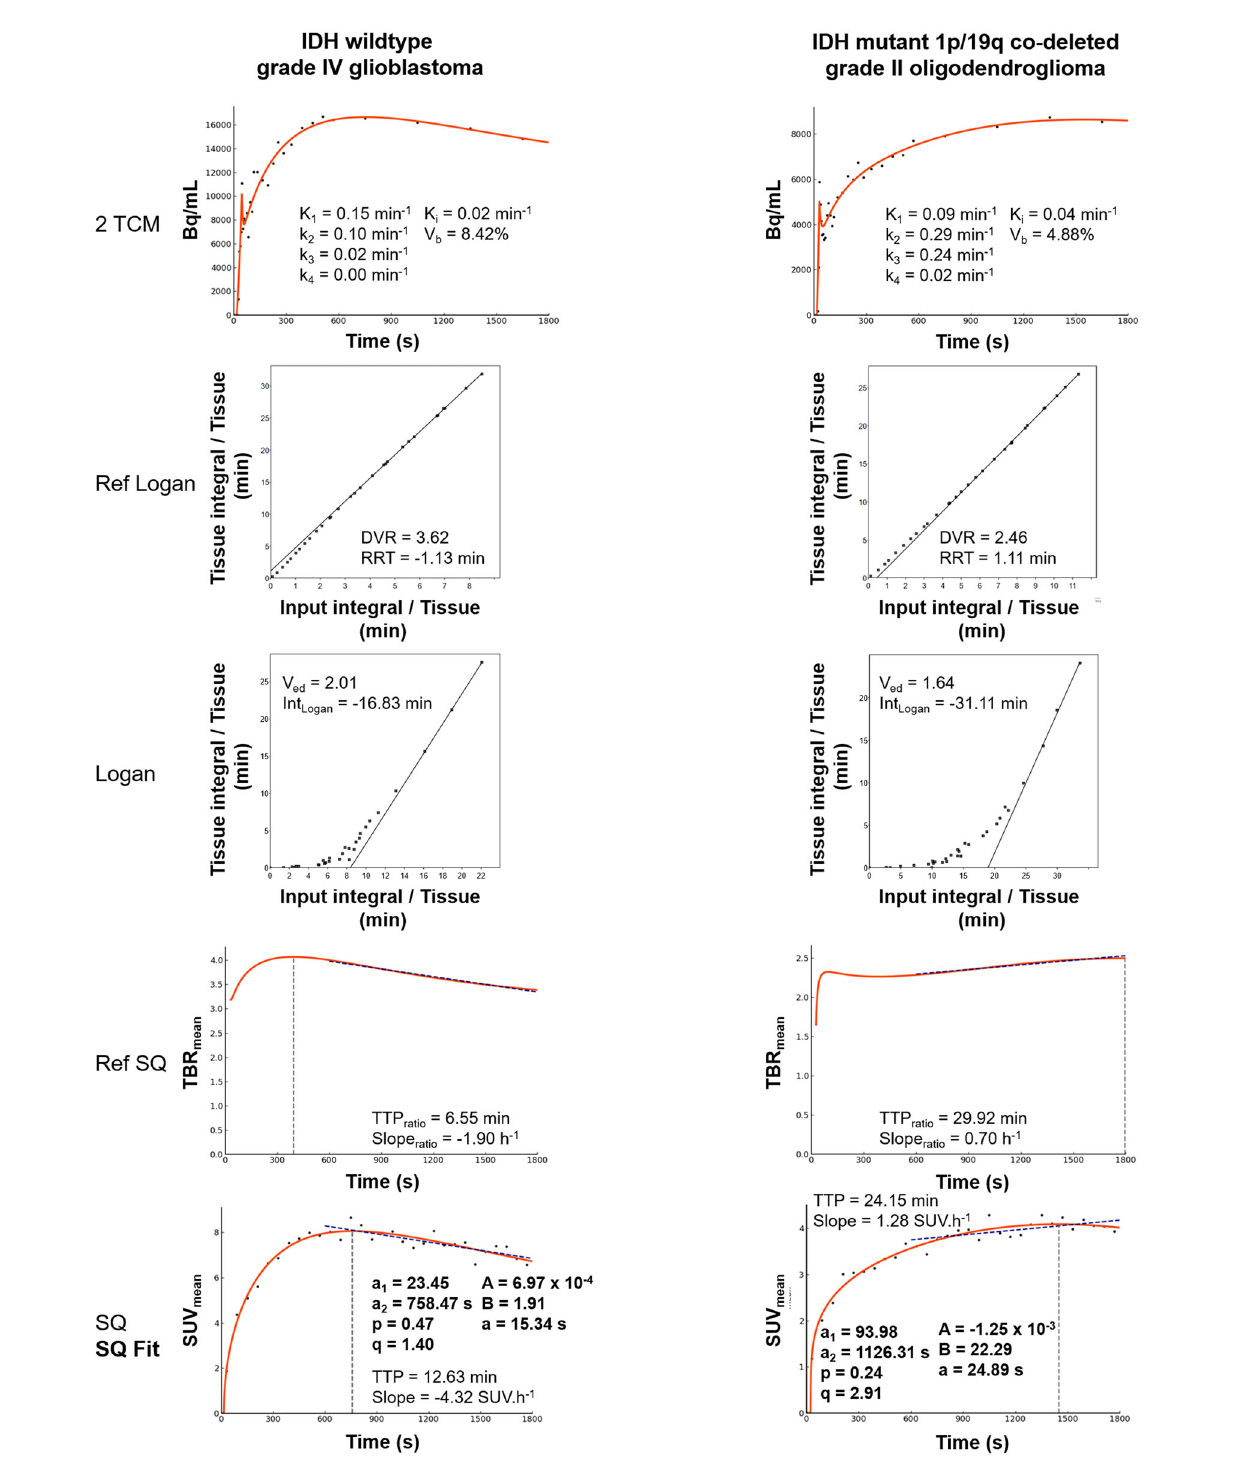
FIGURE 4 | Representative IDH-wild-type grade IV glioblastoma and an IDH-mutant 1p/19q co-deleted grade II oligodendroglioma. Fitted results and parameters extracted from all the dynamic models used in this study are displayed for each of the two patients: semiquantitative model ( SQ ), semiquantitative fi tting parameters ( SQ Fit ), reference semiquantitative model ( Reference SQ ), Logan model with input function ( Logan ), Logan model with reference region ( Reference Logan ), and the two-tissue compartmental model (2TCM). IDH , isocitrate dehydrogenase; TBR , tumor-to-brain ratio.